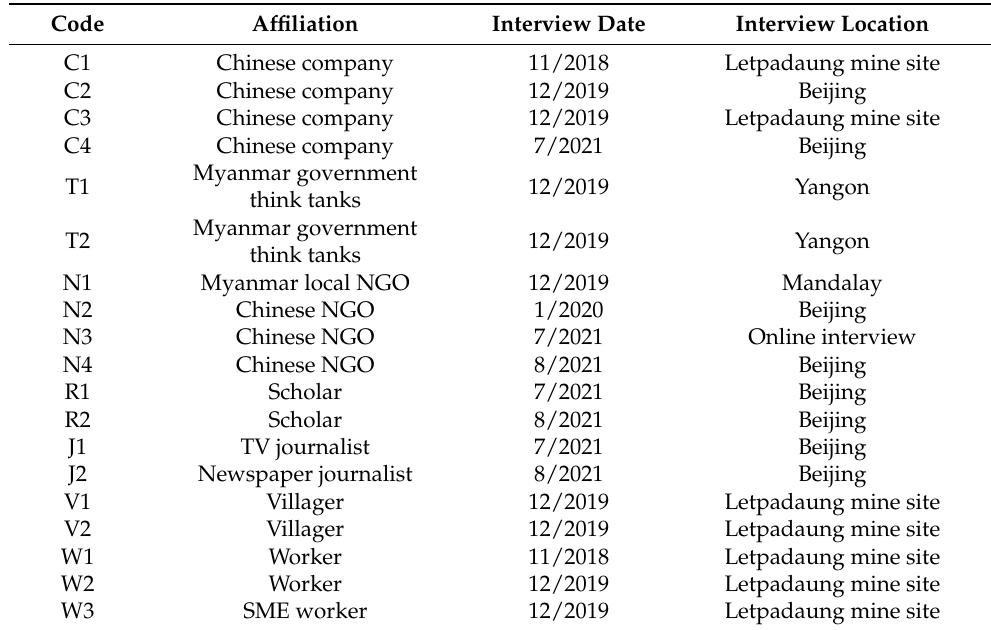
Table A1. Key information about the